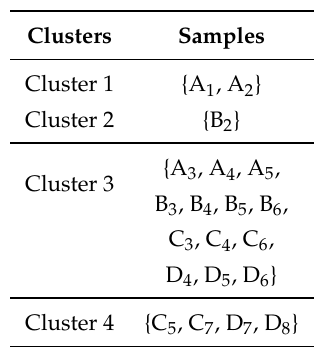
Table 7. Clustered samples based on the similarity of their VOC profile as described by